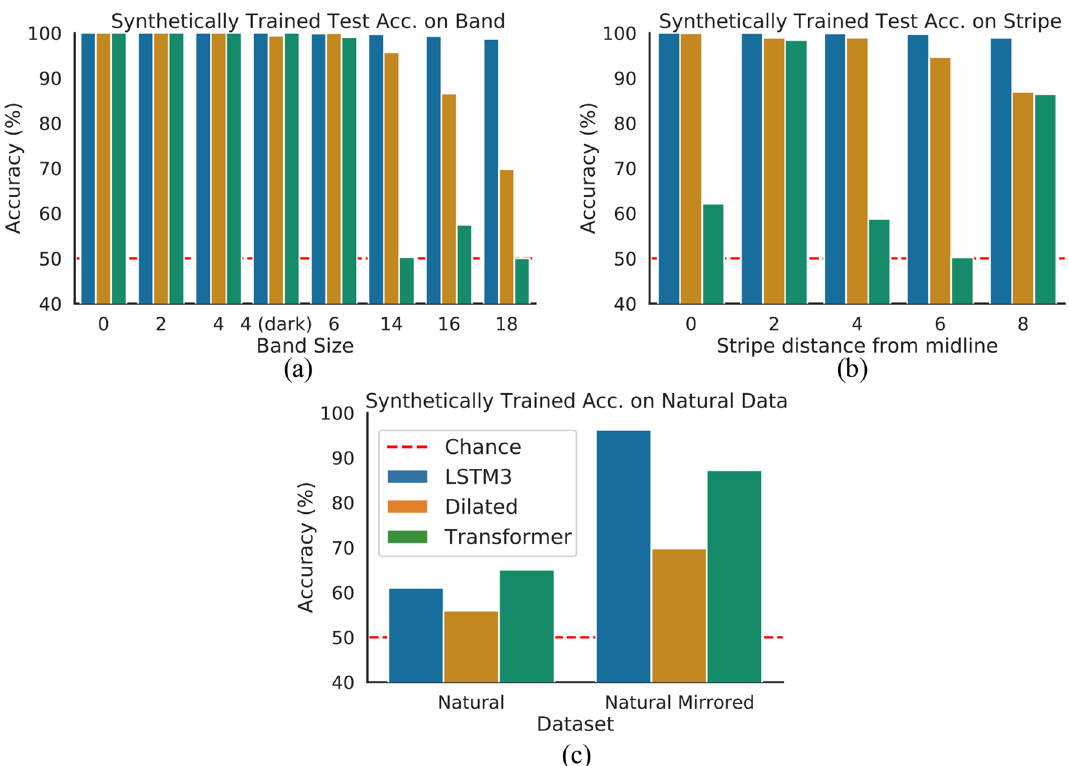
Figure 6. Generalization performance of synthetically trained LSTM3 , Dilated , Transformer . ( a ) Cross-dataset evaluation accuracies on the Band datasets. ( b ) Accuracies on the Stripe datasets. ( c ) Accuracies on